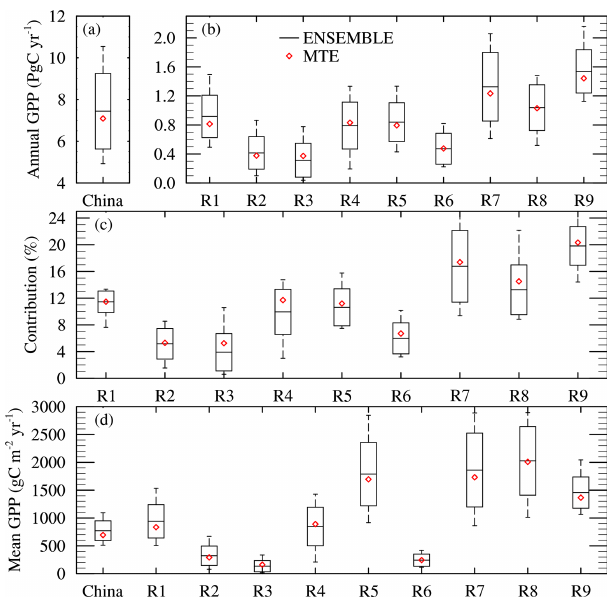
Figure 3. Annual mean GPP from (a) China and (b) each subre- gion; (c) regional contributions to China GPP; (d) annual mean GPP per unit square meters. Horizontal lines at top, middle and bottom in the boxplots represent the maximum, ensemble mean, and mini- mum of multi-model simulations, respectively, whereas the box in- dicates 1 standard deviation. All the results in this figure are aver- aged for the period of 1981–2010 for the MsTMIP SG3 simulation and 1982–2010 for the MTE. Regional abbreviations used on the x axes are defined in Fig. 1a.